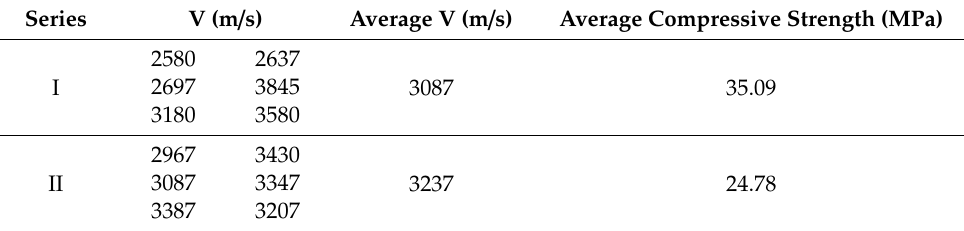
Table 5. Ultrasonic Pulse Velocity (UPV) test of the geopolymer concrete